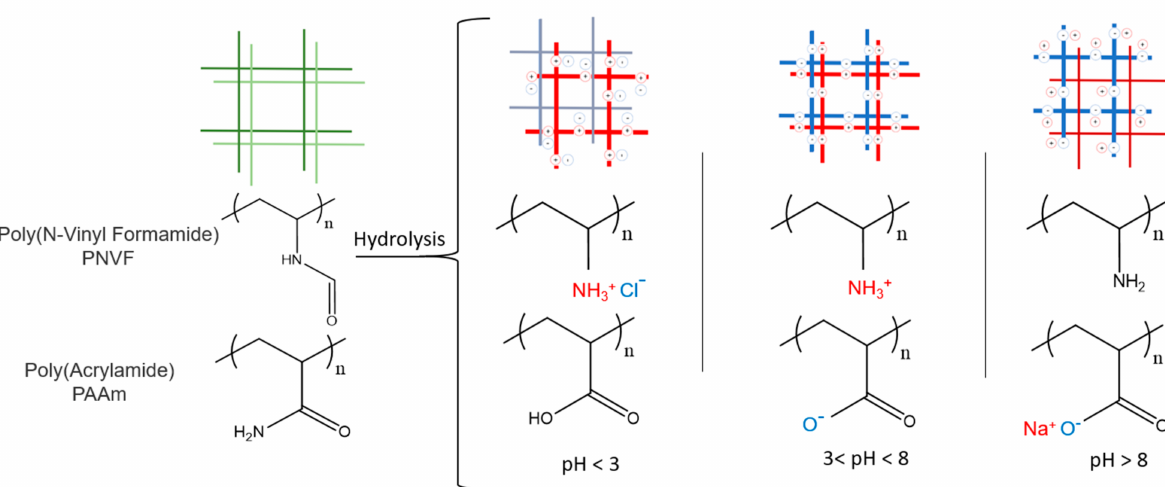
Figure 7. Formation and partial hydrolysis of PNVF and PAAm to PVAm and PAAc. When in an acidic solution with a pH of less then 3 the PVAm is ionized while the PAAc is not, leading to a highly swollen gel due to the osmotic pressure of the mobile counterions associated with the protonated amines. The reverse happens in a solution with a pH greater then 8, the PAAc is ionized with mobile cations while the PVAm is not. However, at intermediate pH values between 3 and 8 networks are both ionized, Thus the polymers can from ionic bonds with each other without mobile counterions. Thus in this state the two networks form a globally neutral hydrogel that deswells. These ionic bonds formed between the two networks lead to the increased mechanical properties